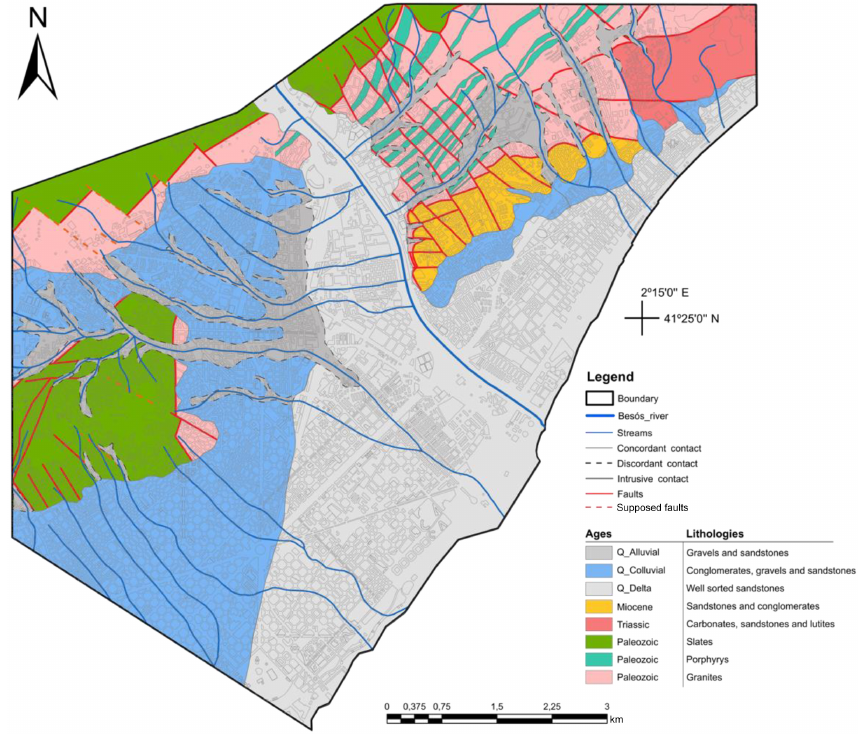
Figure 4. Geological map of Barcelona and surroundings. This geological map was generated considering previous and additional observa- tions performed for this work (see Sect. 3). See characteristics of the different geological units described in Sects. 4.1, 4.2, and